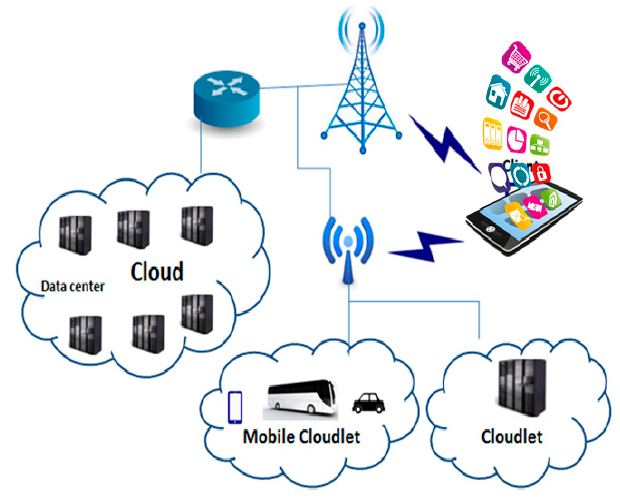
Figure 4. Different cloud platforms.